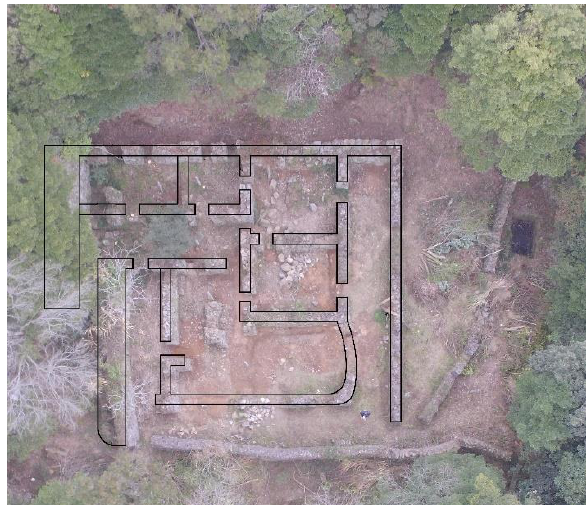
Figure 4 Site of the No.395 cottage in Kuliang, belonging to Dr. H. R. Pakenham, a British medical missionary. With orthophotos, the research team redraw the original plan of this building.